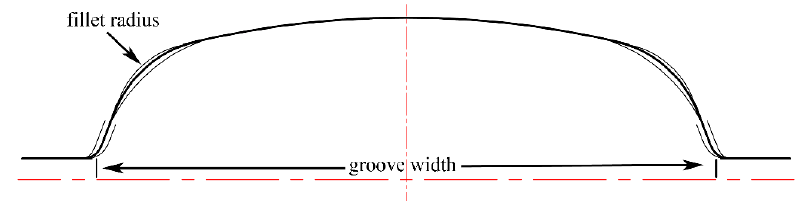
Figure 12. Roll groove parameters: fillet radius and groove width. Table 4. Influencing factors of the surface wrinkle defect for an orthogonal analysis.